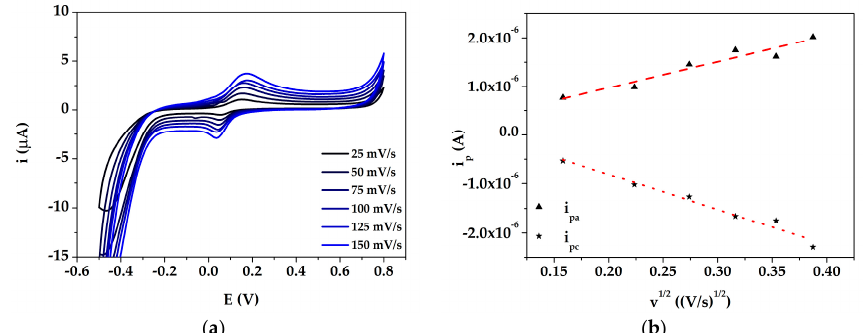
Figure 4. ( a ) Cyclic voltammograms of AuNPs@PANI/GSPEs performed with 50 μ M dopamine in 0.1 M PBS pH 7.0 at different scan rates; ( b ) Linear relationship between i p vs. v 1/2 . Experimental parameters: potential range from − 500 mV to +800 mV; scan rates 25, 50, 75, 100, 150 mV/s.